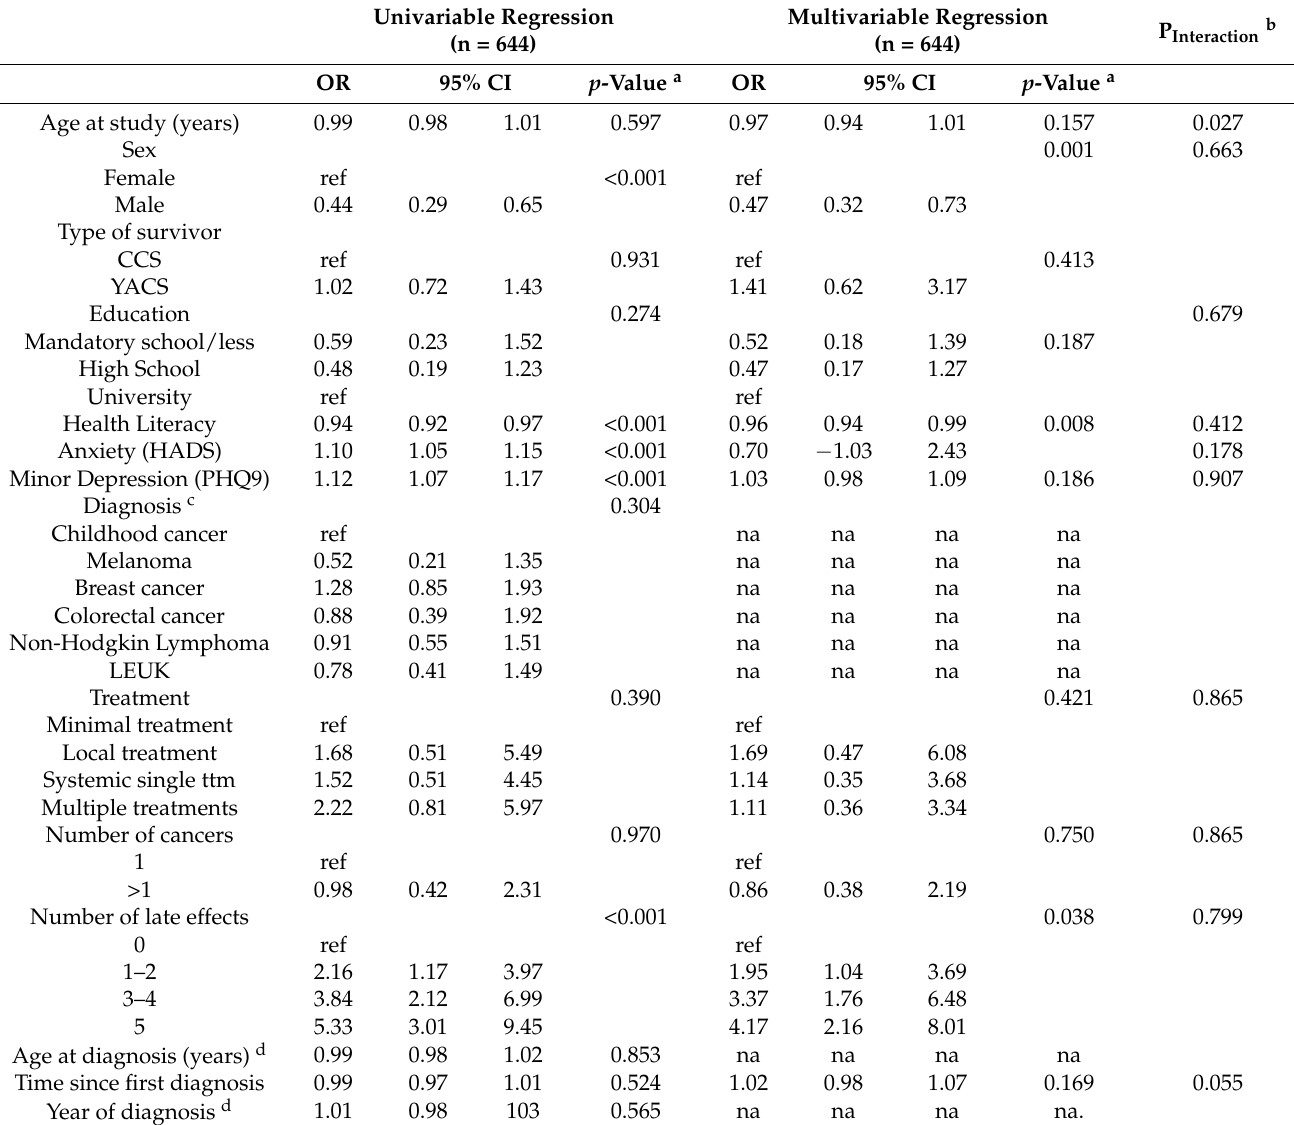
Table 2. Factors associated with not being satisfied with the information received by a medical professional in univariable and multivariable logistic regression models. Univariable Regression Multivariable